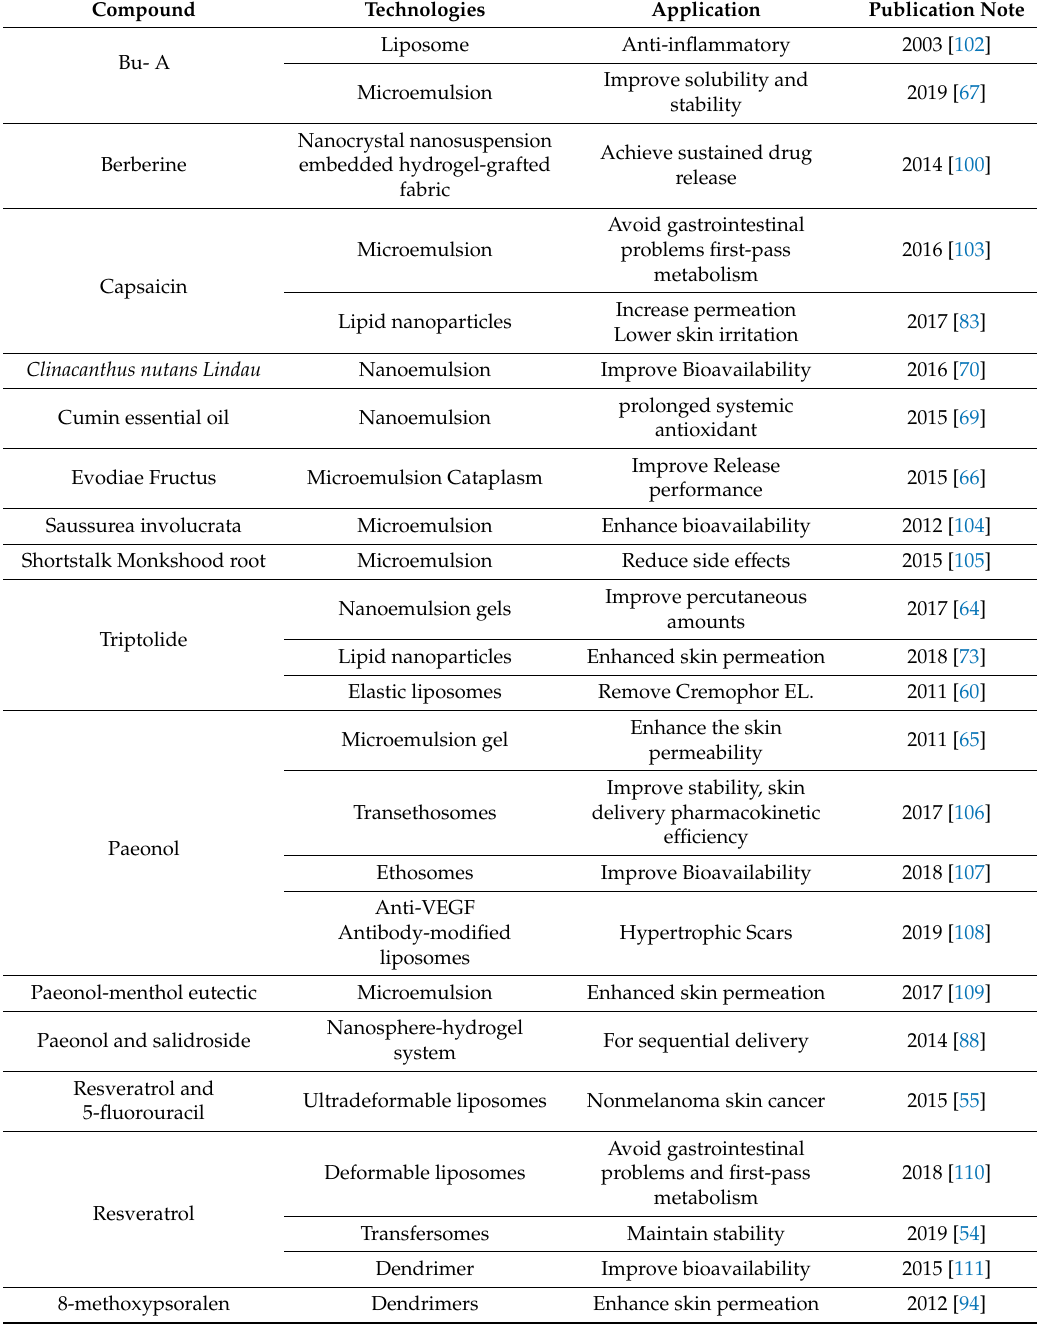
Table 2. Natural product transdermal delivery by the